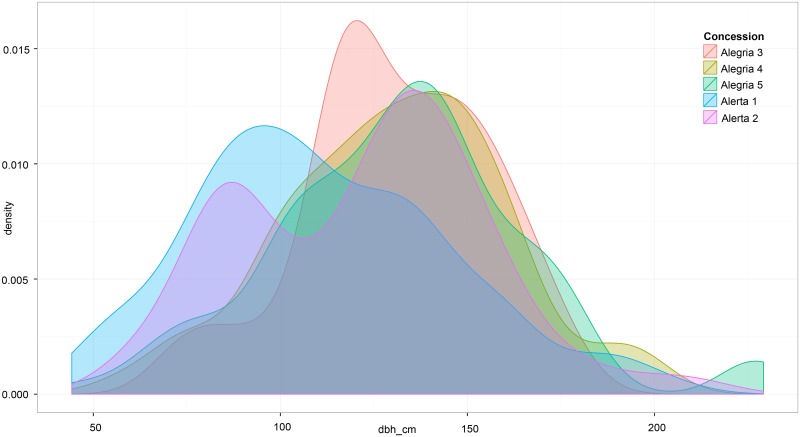
Density plot, or the estimation of the probability density function (Y) of diameter (DBH, X) of 499 Brazil nut trees (≥40 cm DBH).